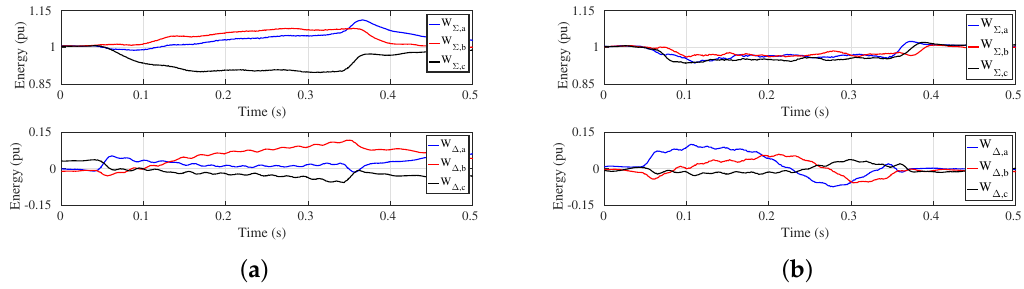
Figure 19. ( a ) W Σ and W ∆ for Scenario 3 without energy controllers and ( b ) with energy